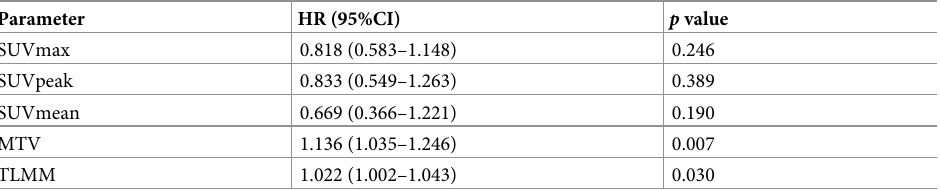
Table 2. Univariate analysis of 11 C-MET PET parameters and